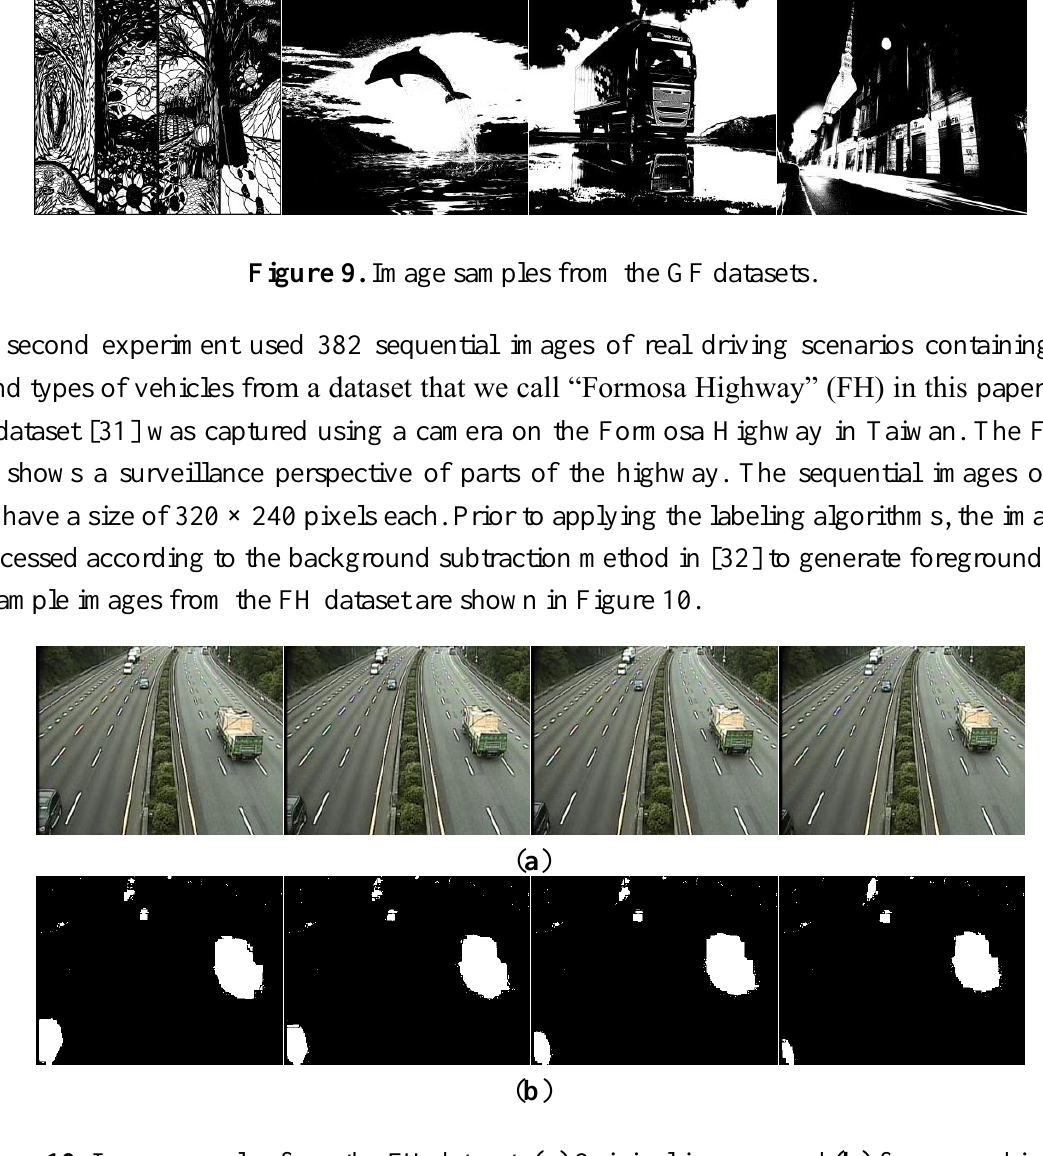
Figure 10. Image samples from the FH dataset. ( a ) Original images, and ( b ) foreground